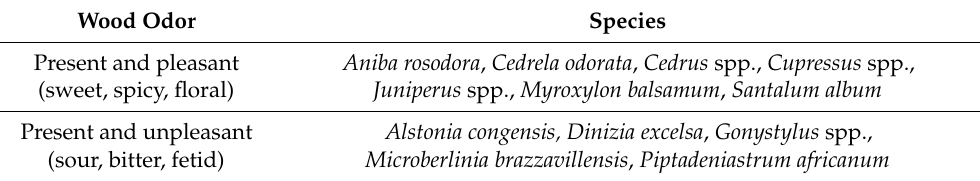
Table 19. Examples of species for different wood odors. Wood Odor